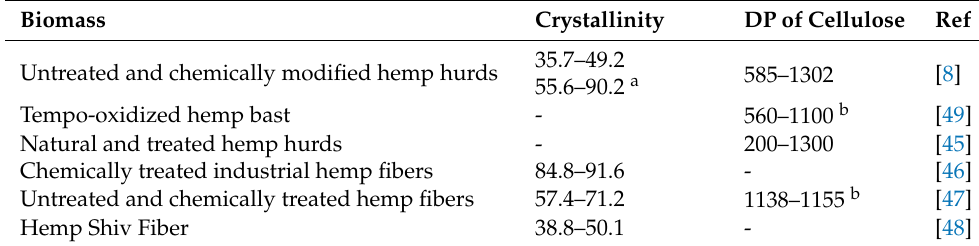
Table 2. Crystallinity and degree of polymerization of cellulose in industrial hemp biomass.